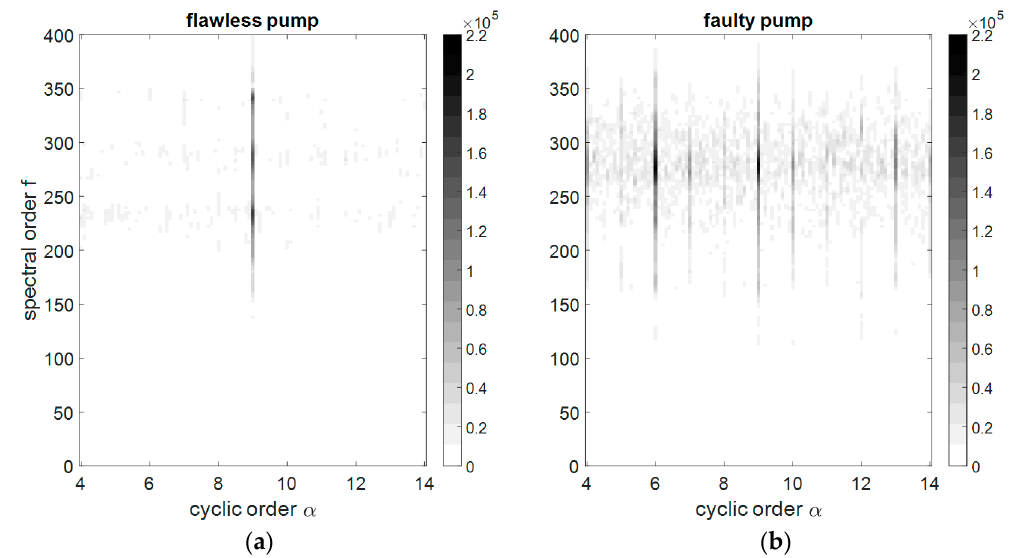
Figure 12. SCD around the cyclic order 9 for the signals acquired with sensor 1 at 1500 r/min and 150 bar ( ∆ α = 0.1, ∆ f = 2.5). ( a ) flawless pump; ( b ) faulty pump.